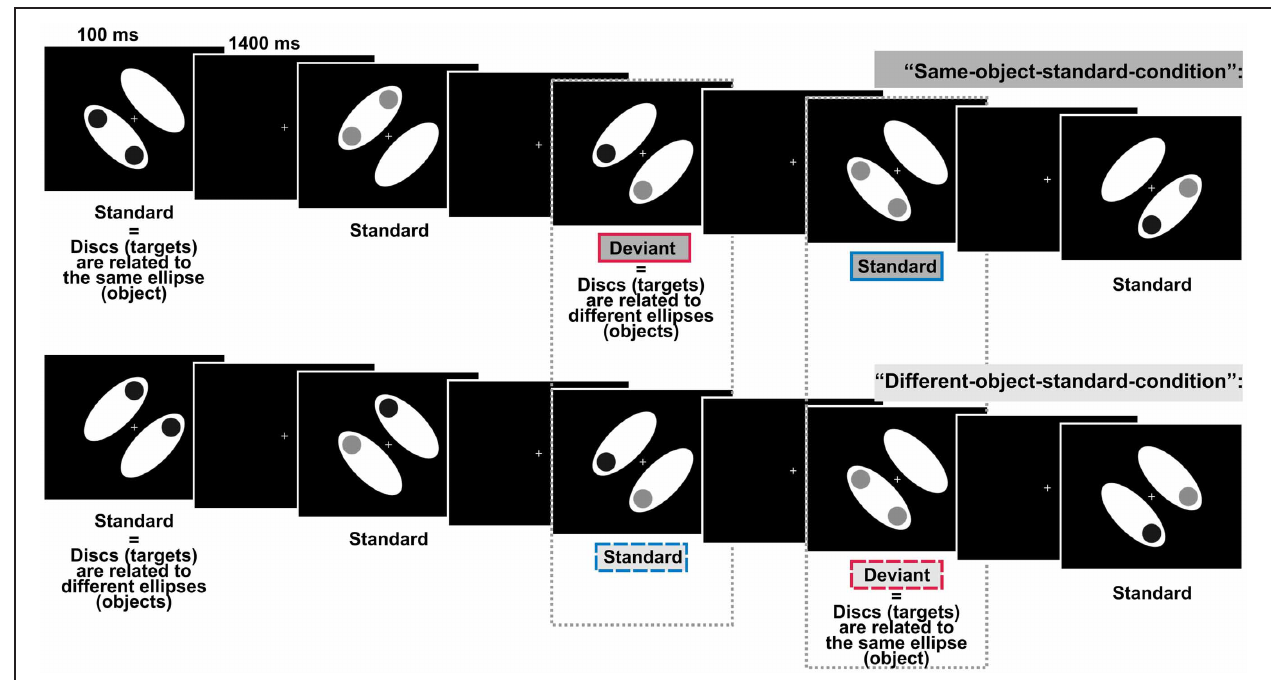
FIGURE 1 | Schematic display sequences presented in the two experimental conditions defined by comprising different object-related regularities. In both conditions, regularly presented standard displays and irregularly presented deviant displays differed only with respect to the relation between the discs and the ellipses (the objects), i.e., discs could either belong to the same ellipse or to different ellipses. Participants had to evaluate whether the two discs (the targets) were of the same or of